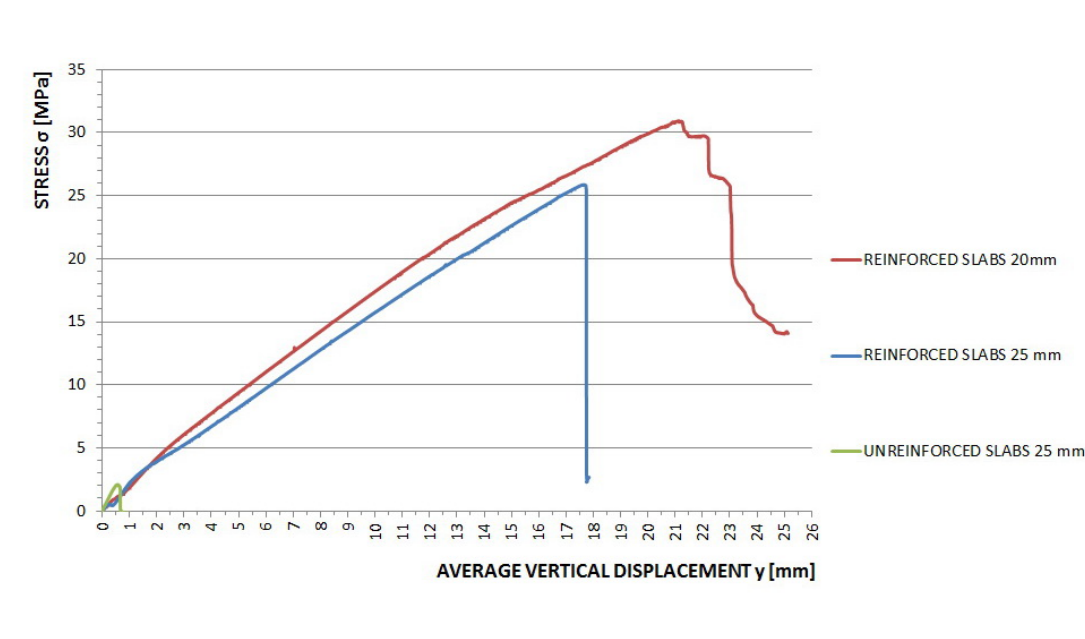
Figure 6. The flexural testing of TRLC slabs with 2D carbon textile.